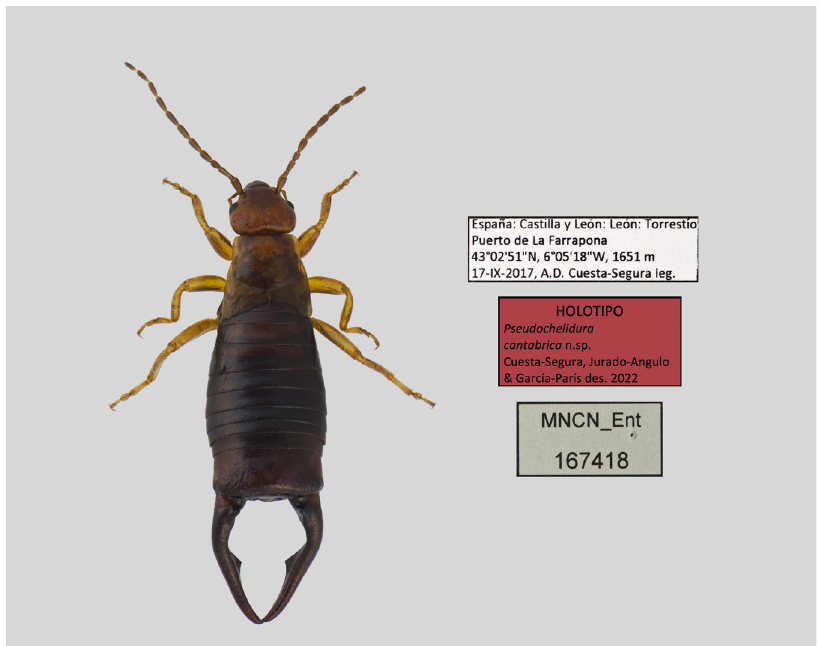
Fig. 6. Pseudochelidura cantabrica Cuesta-Segura, Jurado-Angulo & García-París sp. nov., holotype, ♂ (MNCN_Ent 167418), deposited in the collection of the Museo Nacional de Ciencias Naturales (MNCN,